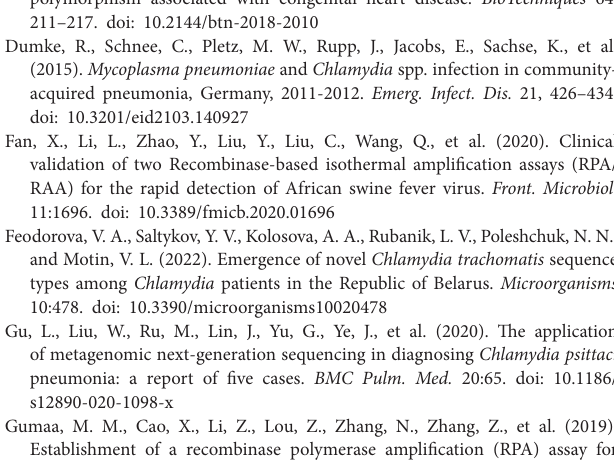
Supplementary Figure S1 | Evaluation of the RAA-LF assay for detection of active Chlamydia psittaci infection in mice. Fresh feces samples from group 1 (A) , group 2 (B) and naïve mice (C) were tested by the developed RAA-LF assay. 1, 3 7, 10, 14, 17, 20: days at post-infection. N: negative control. N1– N4: naïve mice. A positive result was determined when both the low line of test (T) and the upper line of control (C) developed. Only C line occurrence indicated a negative